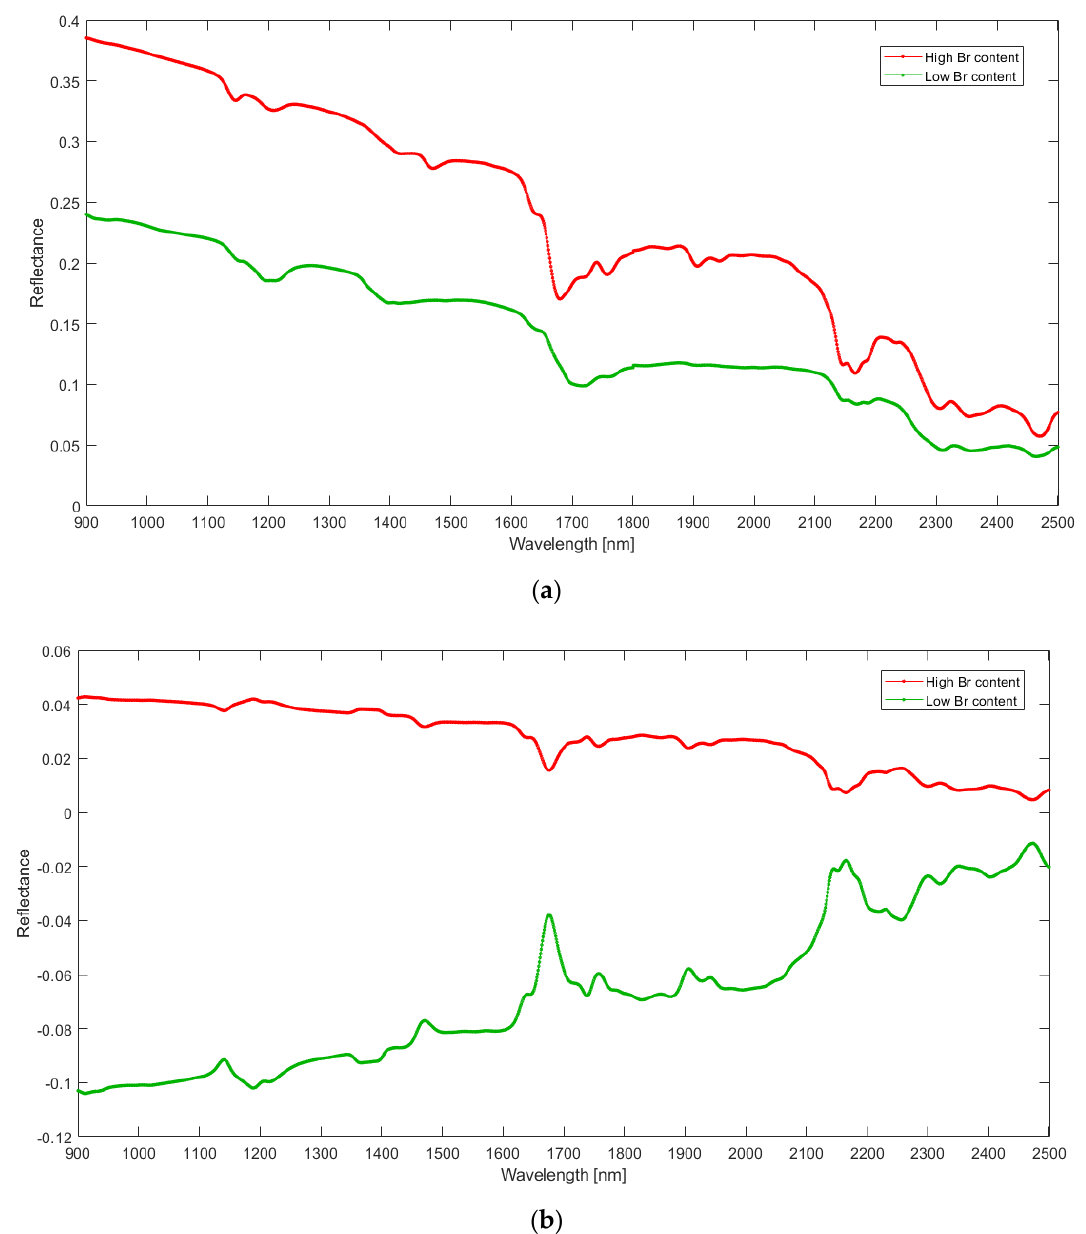
Figure 3. Mean raw ( a ) and pre-processed ( b ) reflectance spectra according to Br content classes. The score plot of the performed PCAs, as reported in Figure 4a, shows that the classes of Br content are clustered according to the first PC. The first PC explains a variance equal